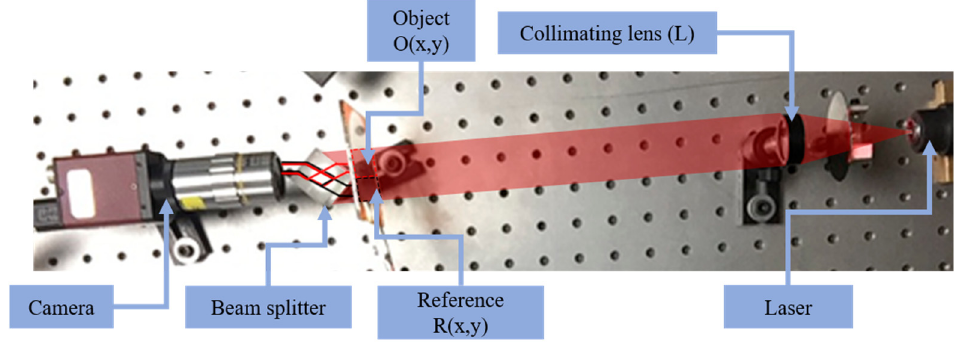
Figure 3. The optical arrangement of digital holographic microscope.